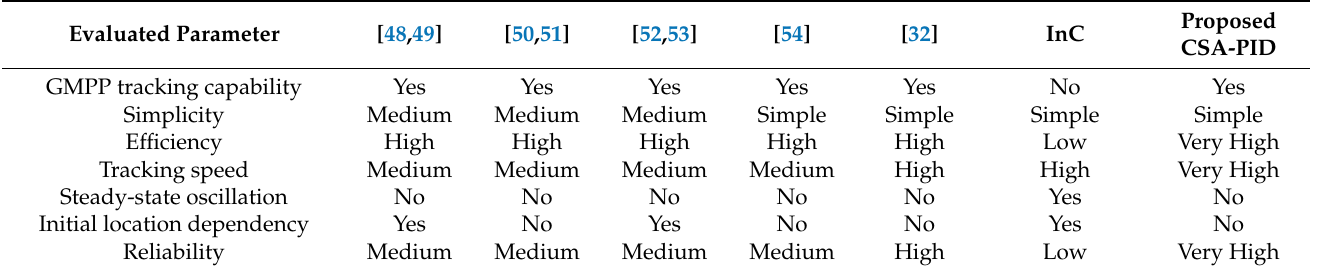
Table 8. Comparison of the proposed technique with other MPPT